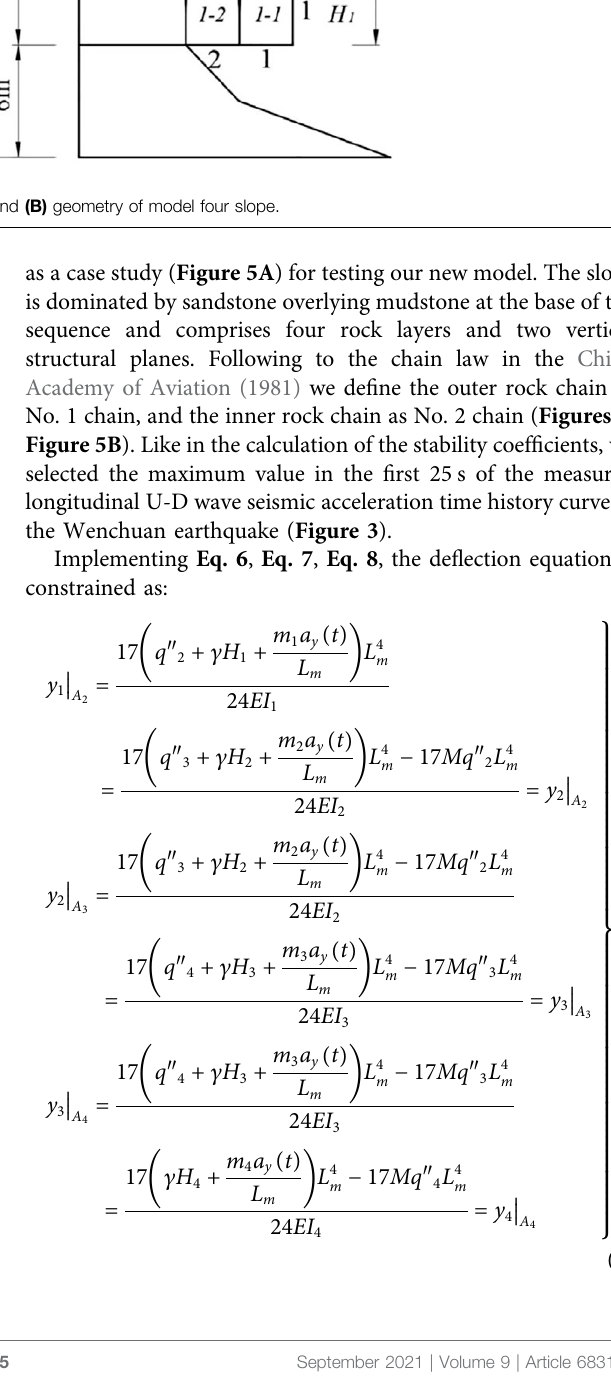
Frontiers in Earth Science |